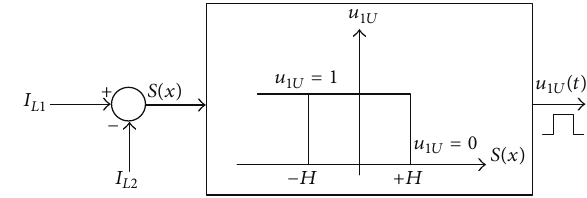
Figure 7: Logic scheme of sliding-mode